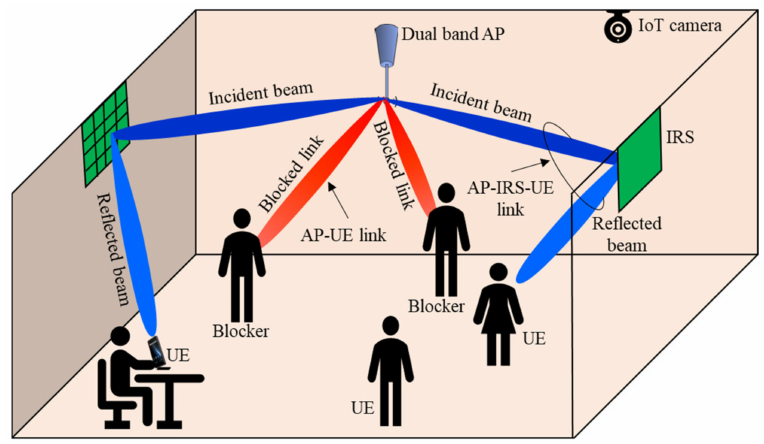
Figure 1. The network architecture of multi IRS aided MIMO communication